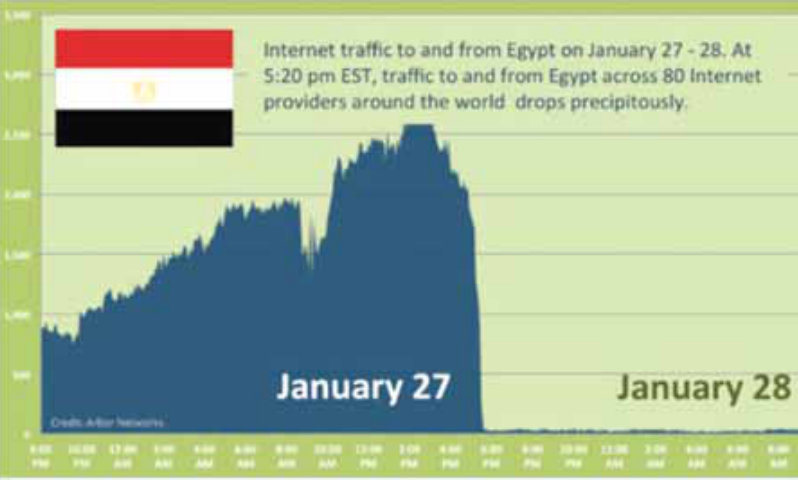
Source : Labovitz (2011). Figure 2: Main usage of Facebook throughout demonstrations